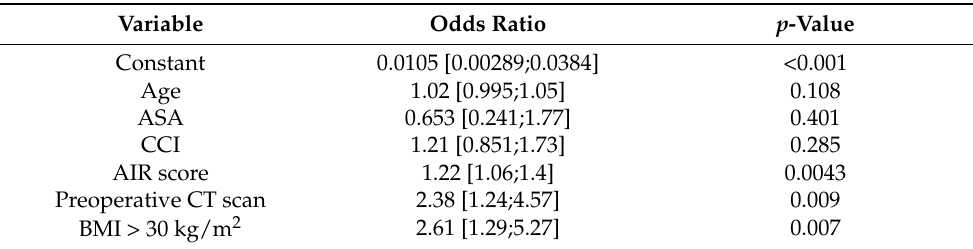
Figure 1. Flowchart of patient selection. Table 2. Multivariable logistic regression model for technically challenging laparoscopic appen- dectomy, difficulty Grade 4–5. BMI, body mass index; ASA, American Society of Anaesthesiology classification; CCI, Charlson comorbidity index; AIR score, appendicitis inflammatory response score; CT, computed